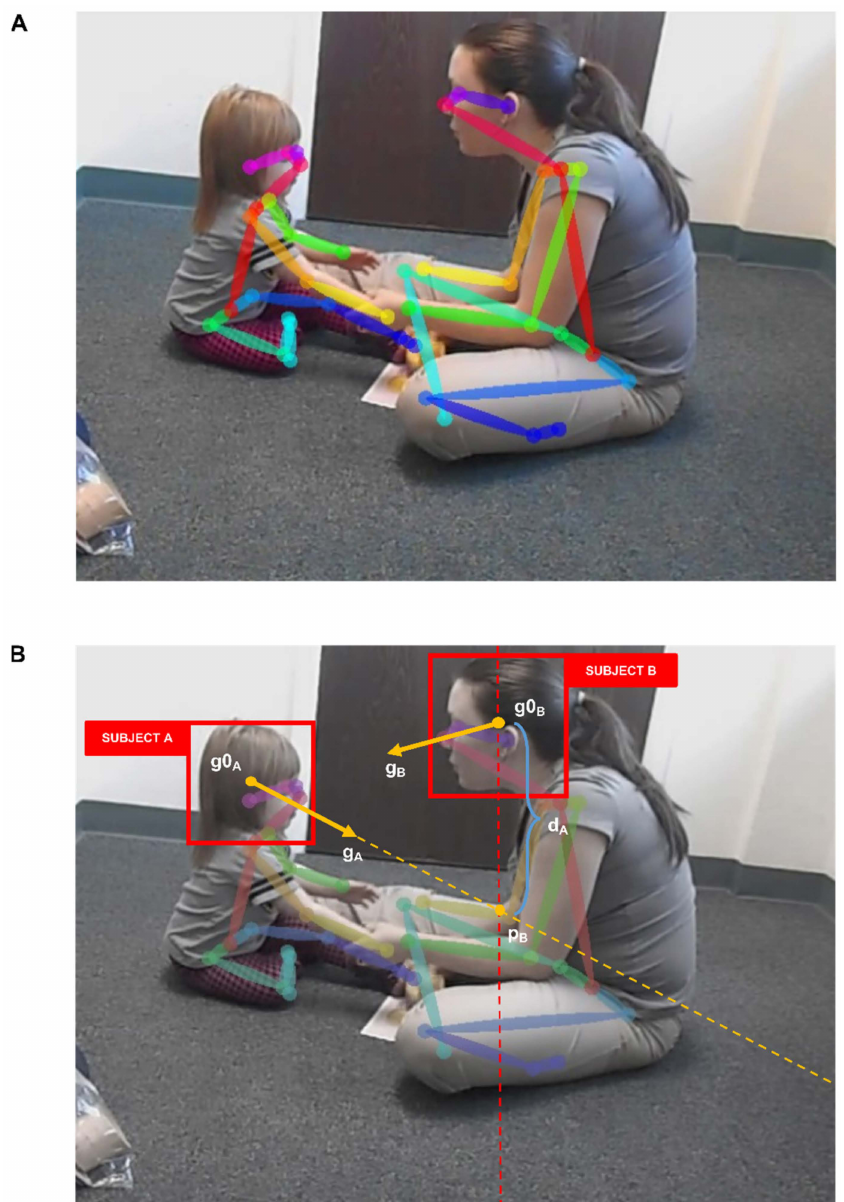
Figure 1. Eye-contact detection model (EYE-C). The images represent the output of the model run on a video example from YouTube (the video is licensed under a CC licence, and was kindly offered by White, R. [Good Behavior Beginnings]. (15 May 2015). How to Redirect Escape Behavior in 2 year olds (Video). YouTube. https://www.youtube.com/watch?v=GzGLF8GlPmo, accessed on 28 September 2021); ( A ) OpenPose body keypoints output [47]; ( B ) Gaze360 gaze vectors output [48] and eye- contact detection system; g0 A : headbox center of subject A; g0 A /g0 B : headbox center of subject A/B; g A /g B : gaze vector of subject A/B; p A : intersection point between gaze of subject B and headbox x-axis coordinates of subject A; d B : distance (pixels) between p A and g0 A